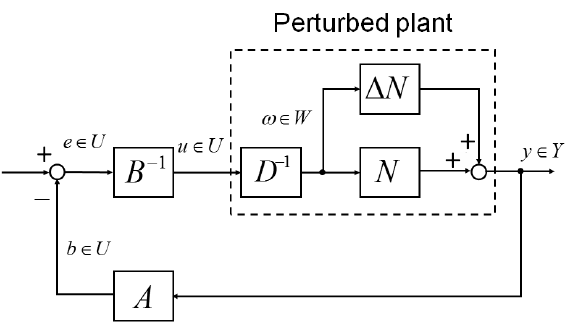
Figure 7. The stabilized feedback system in the overall system of Figure